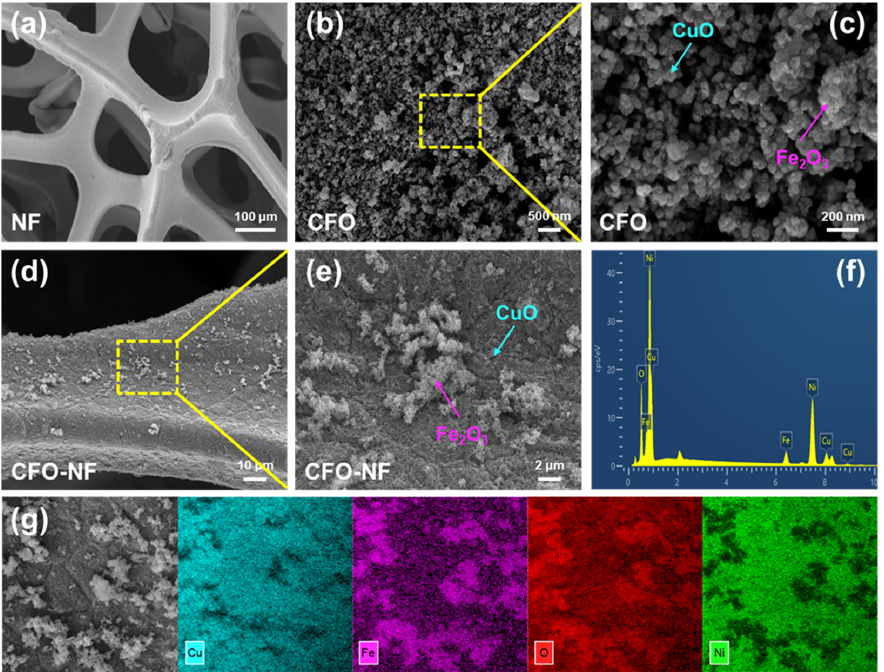
Figure 1. SEM images of ( a ) NF, ( b , c ) CFO, and ( d , e ) CFO-NF (the yellow box indicates the enlarged portion); ( f ) EDS element analysis of CFO-NF, and ( g ) EDS mappings of CFO-NF.